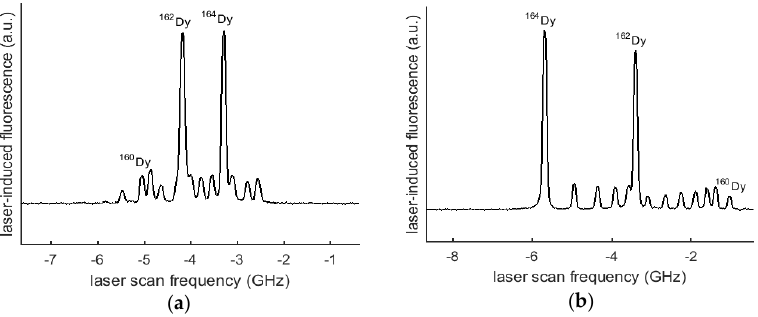
Figure 2. Laser-induced fluorescence spectrum of the transition 4 f 9 ( 6 H°)5 d ( 7 I°)6 s 8 I 17/2 °–4 f 9 ( 6 H°)5 d ( 7 H°)6 p 15/2 at 436.135 nm in Dy II, showing the advantage of viewing the same transition in two different laser beam/ion beam geometries: ( a ) Anti-parallel; ( b ) Parallel. It is important to note that in the large separation any pair of peaks corresponding to two different isotopes shown in these spectra is predominantly a differential Doppler shift arising from the